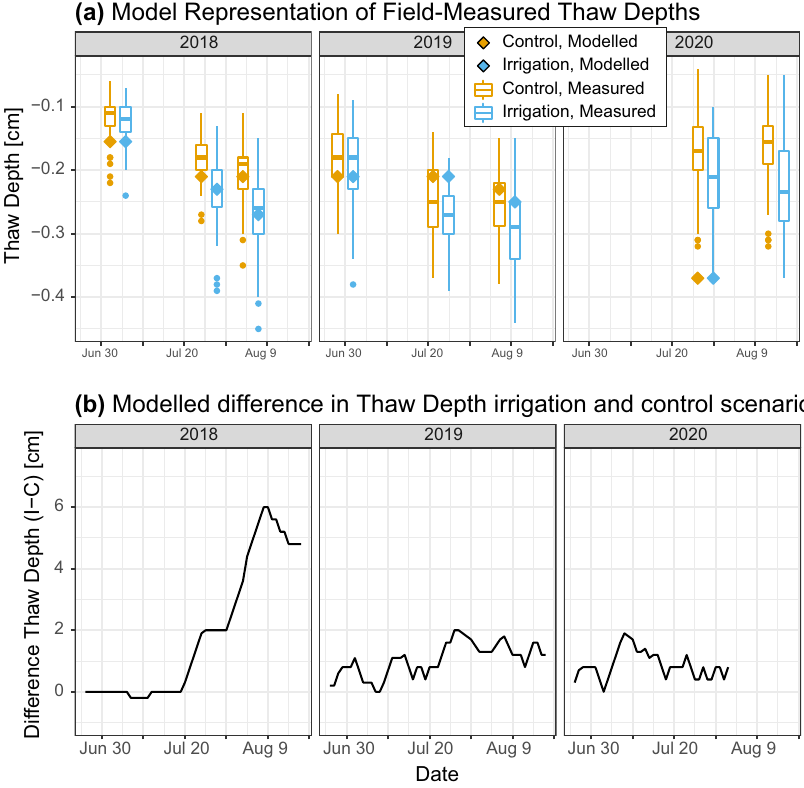
Fig. 2 Model representation of the irrigation experiment. a Modelled and measured thaw depth for 2018 – 2020 with mean- fi eld measurement values. Boxplots for measured thaw depths represent all individual measurements in irrigated (blue) and control (orange) plots ( n = 90 per box). Centre lines represent the median, box limits represent upper and lower quartiles, whiskers represent 1.5 times the interquartile range and points represent outliers. b Modelled difference between irrigation and control scenario, smoothed with a 5-day moving average. Modelled data are only available up until the end